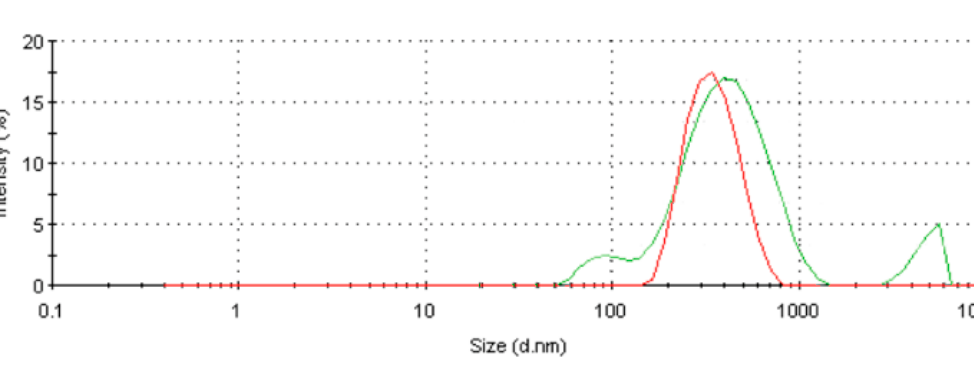
Figure 4. F-5 (red) and F-7 (green) size distribution . Table 3. Size and zeta potential of each formulation.